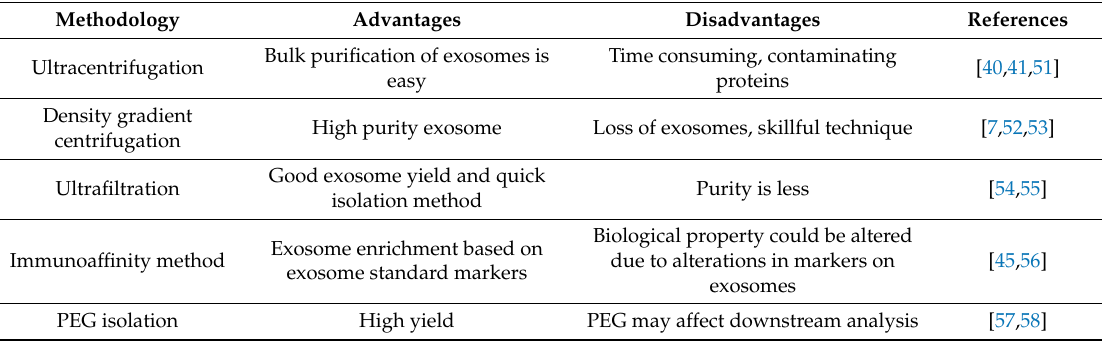
Table 1. Exosome purification